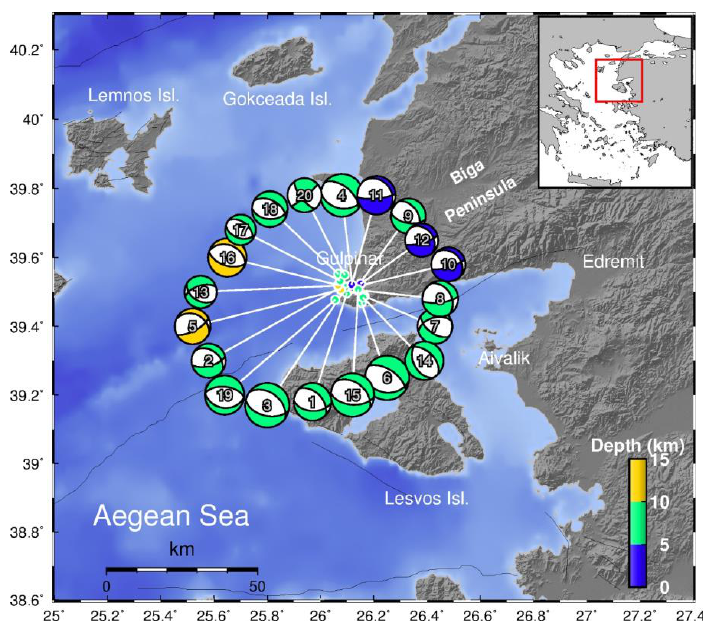
Figure 7. Map of northeast Aegean with published focal mechanisms by MT inversion (NOA solutions using the ISOLA code by [43]; beachball numbers correspond to events in Table 1). Thin black lines are active faults from the NOAFaults database [3].